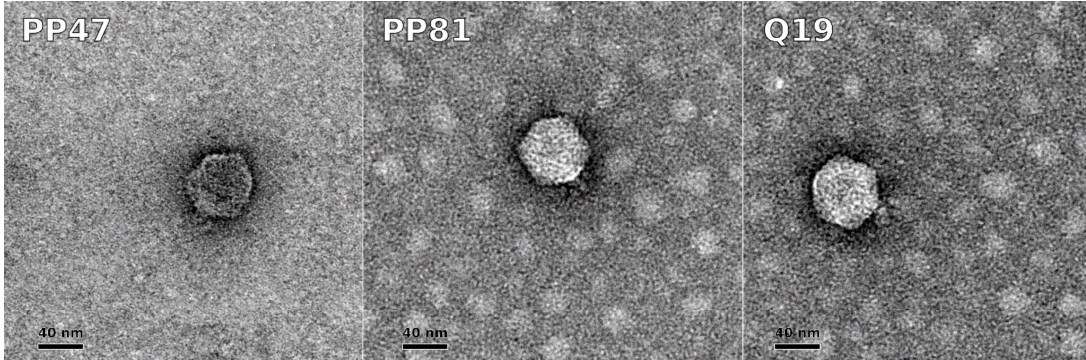
Figure 2. Transmission electron microscopy of bacteriophages PP47, PP81, and Q19. Staining was with 1% uranyl acetate. The scale bar is 40 nm.